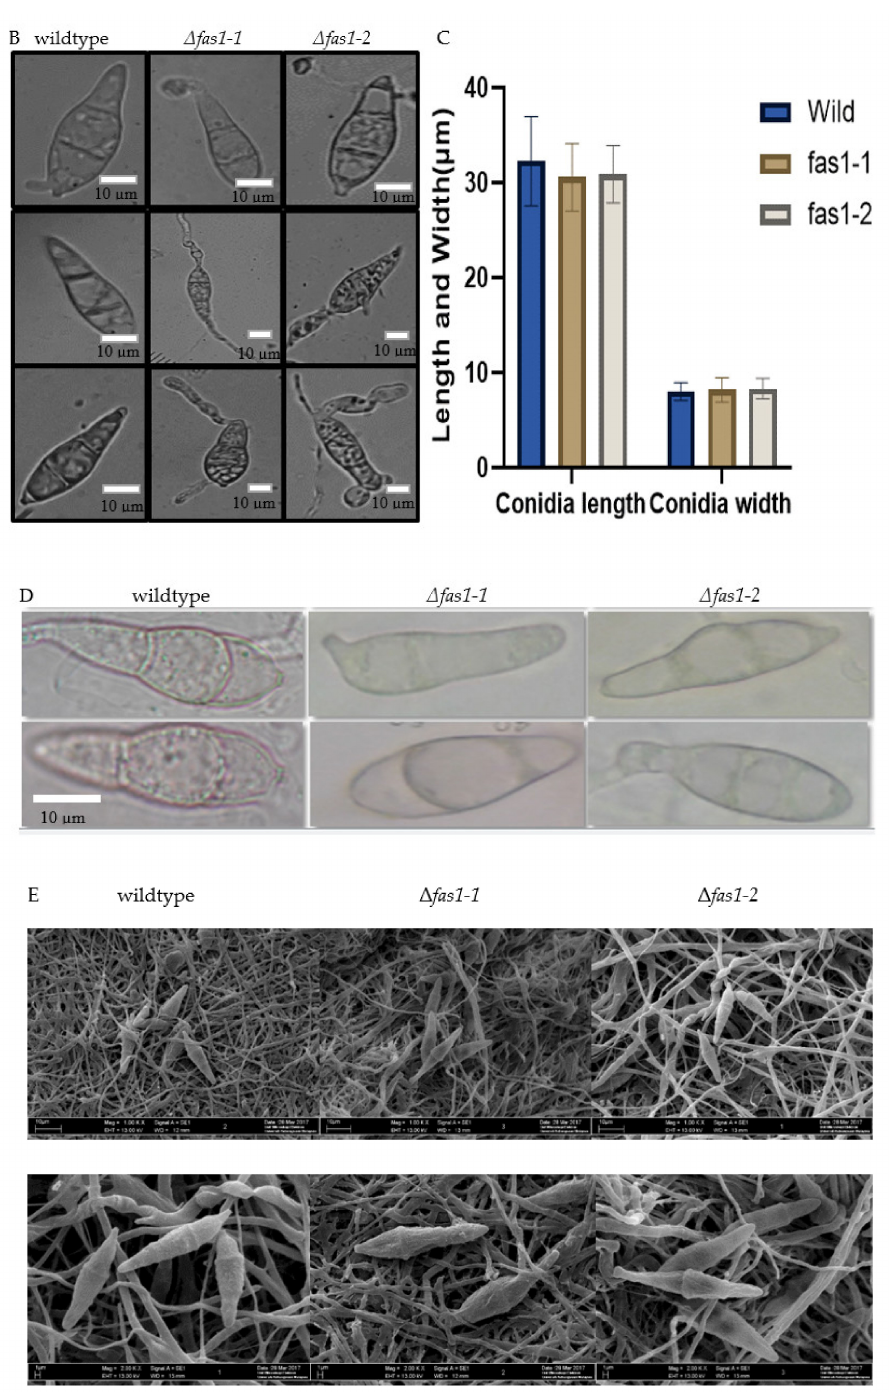
Figure 8. E ff ect of FAS1 deletions on conidiogenesis, appressorial formation and vegetative growth. ( A ) Light microscopy of conidia cultured on oatmeal agar 10 days post-incubation at 26 ◦ C. Basal appendage formation observed where conidia is attached to conidiophores. Magnification 100 × light microscope. Bar = 10 µ m. ( B ) Appressorium formation of conidia inoculated onto plastic cover slips in a moist chamber at 24 ◦ C. ( C ) Size measurement of conidia length and width in micrometer, 10 days post-inoculation at temperature of 26 ◦ C. Error bars represent the standard deviation. ( D ) Appearance of wildtype, mutant fas1-1 and mutant fas1-2 spore formation after 10 days of incubation on complete medium at temperature of 26 ◦ C. Magnification 100x light microscope. ( E ) Scanning electron microscope image of wildtype, mutant fas1-1 and mutant fas1-2 spore after 10 days of incubation on complete medium at temperature of 26 ◦ C. Magnification 1000 × and 2000 × of scanning electron